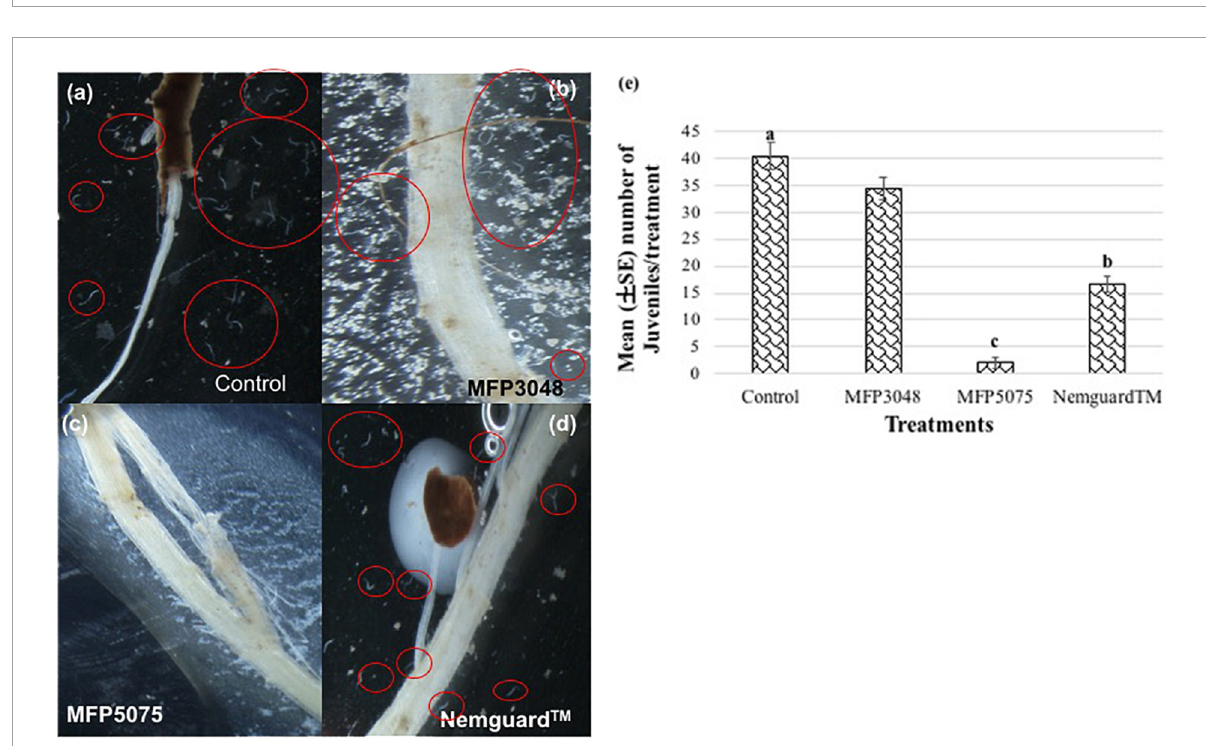
FIGURE3 Attraction of Globodera rostochiensis J2 toward potato roots observed at 8 × magnification: (a) Control; (b) MFP3048 treatment; (c) MFP5075 treatment; (d) Nemguard TM treatment; (e) Effect of products on the attraction of PCN J2. Values represented in graph by the same letters are not significantly different from each other ( p ≤ 0.05). Individual and cluster of nematodes are indicated using red circles.